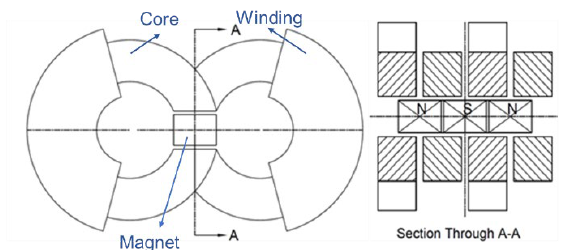
Figure 2. The configuration of the moving magnet linear motor.